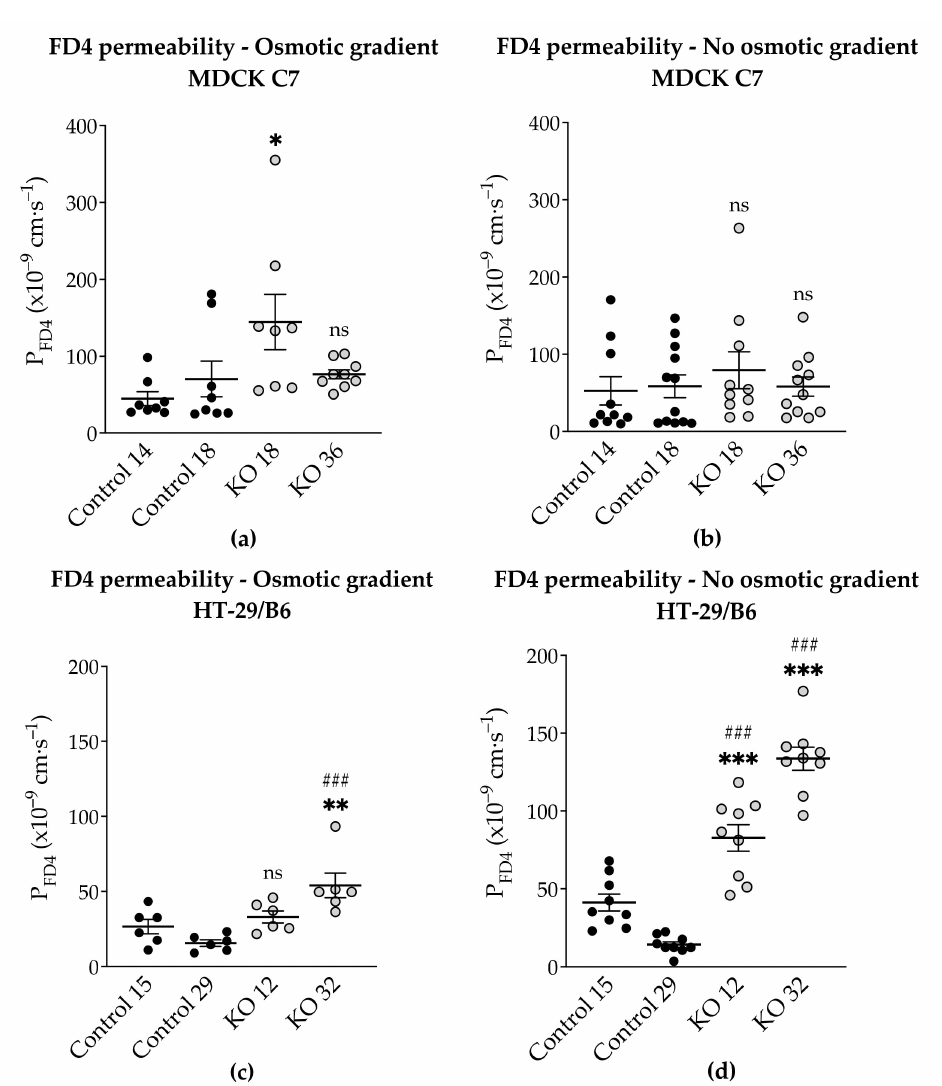
Figure 6. Functional analysis of angulin-1 knockout in MDCK C7 and HT-29/B6 cells. Effect of angulin-1 knockout on permeability for 4-kDa FITC-dextran (FD4) in MDCK C7 cells under an ( a ) osmotic gradient and ( b ) isosmotic condition. Permeability was increased only in the KO 18 clone under an osmotic gradient ( n = 8–10). Effect of angulin-1 knockout on permeability for FD4 in HT-29/B6 cells under an ( c ) osmotic gradient and ( d ) isosmotic condition. Permeability was increased in both knockout clones under isosmotic conditions ( n = 6–9), under osmotic gradient only the KO 32 clone showed an increase in permeability. Statistical analysis was performed using one-way ANOVA test was used to compare between the four clones in both cell lines (ns: not significant, MDCK C7: * p ≤ 0.05 with regard to control 14 and HT-29/B6: ** p ≤ 0.01, *** p ≤ 0.001 with regard to control 15 and ### p ≤ 0.001 with regard to control